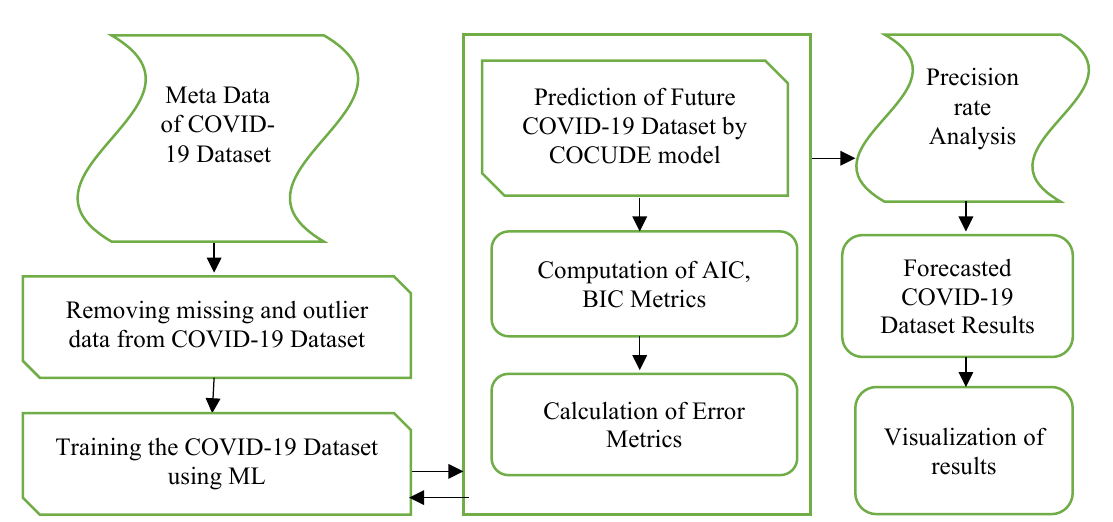
Fig. 1. Block diagram of the proposed COCUDE mode